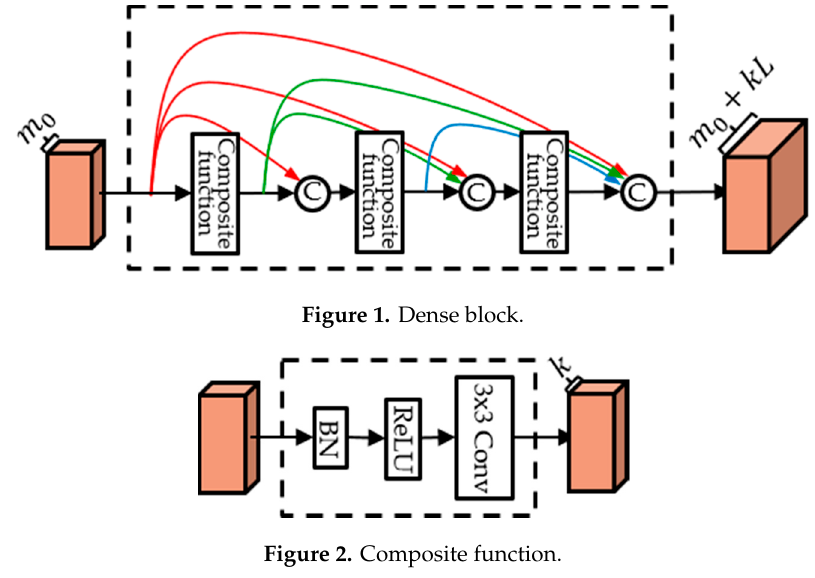
Figure 2. Composite function. Figure 2. Composite